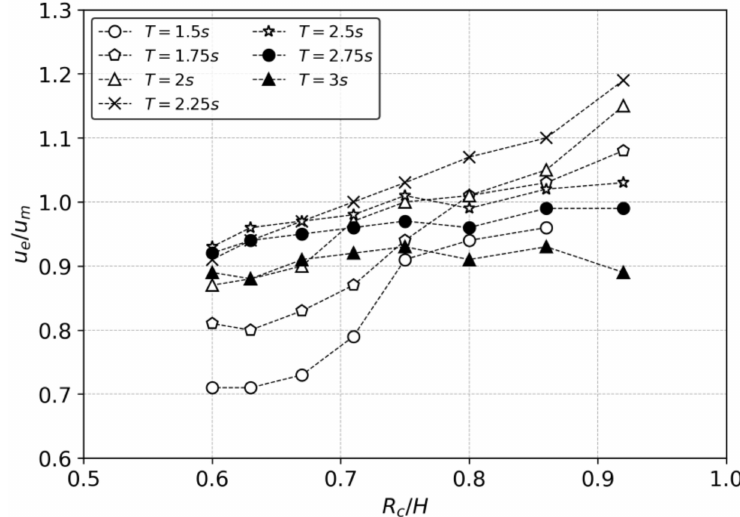
Figure 10. Estimation of the OFV relative to the measurements in the different wave conditions.